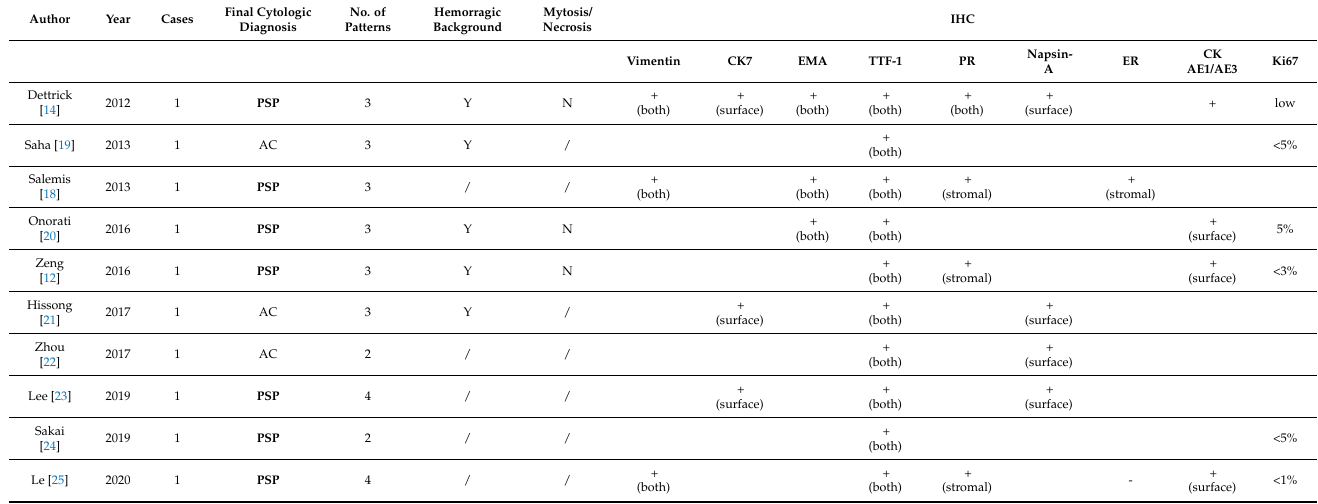
Table 2. Summary of the PSP cytological findings in CT-guided FNAs described in Literature in the last 10